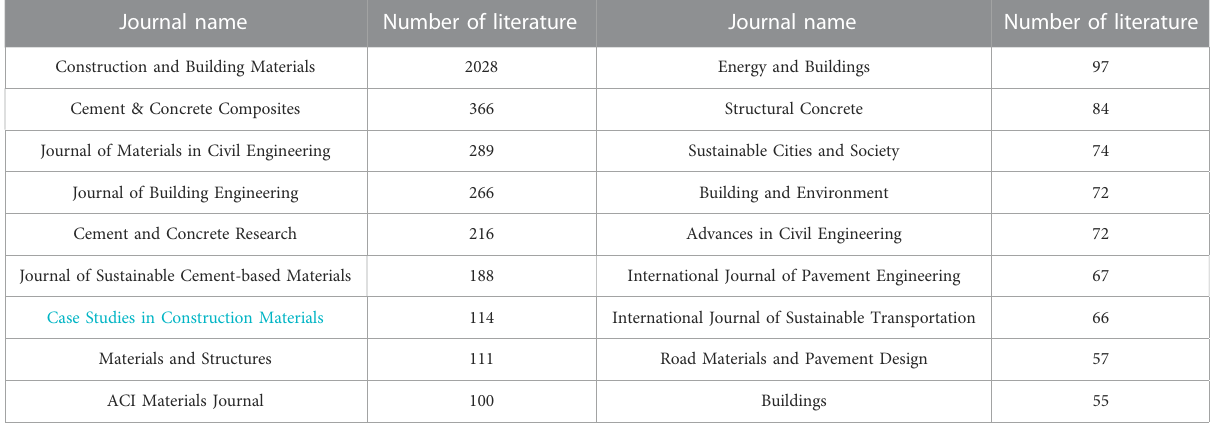
TABLE 3 Distribution of high-frequency journals in the fi eld of ecological concrete